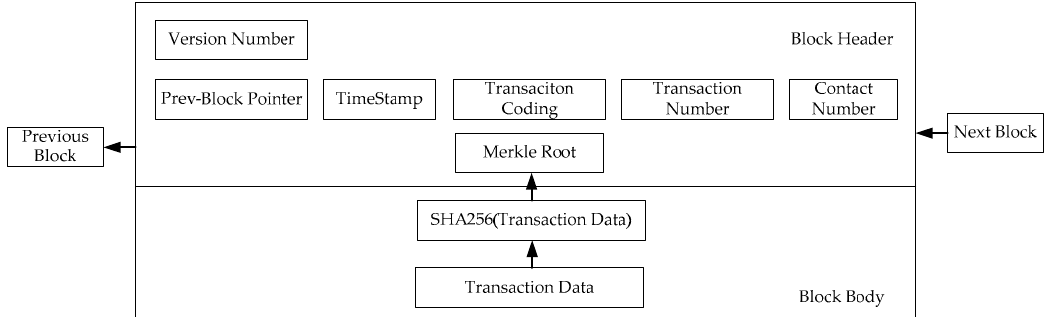
Figure 3. The structure diagram of Block.